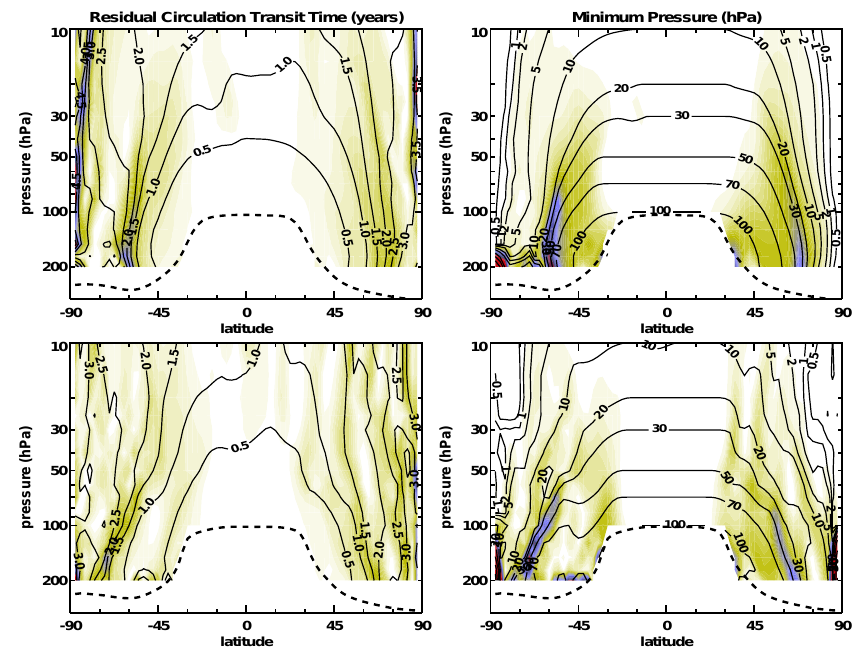
Fig. 4. As Fig. 3 but for JRA25 (top) and ERA40 (bottom) for 1979–2001 (same units for color shading).